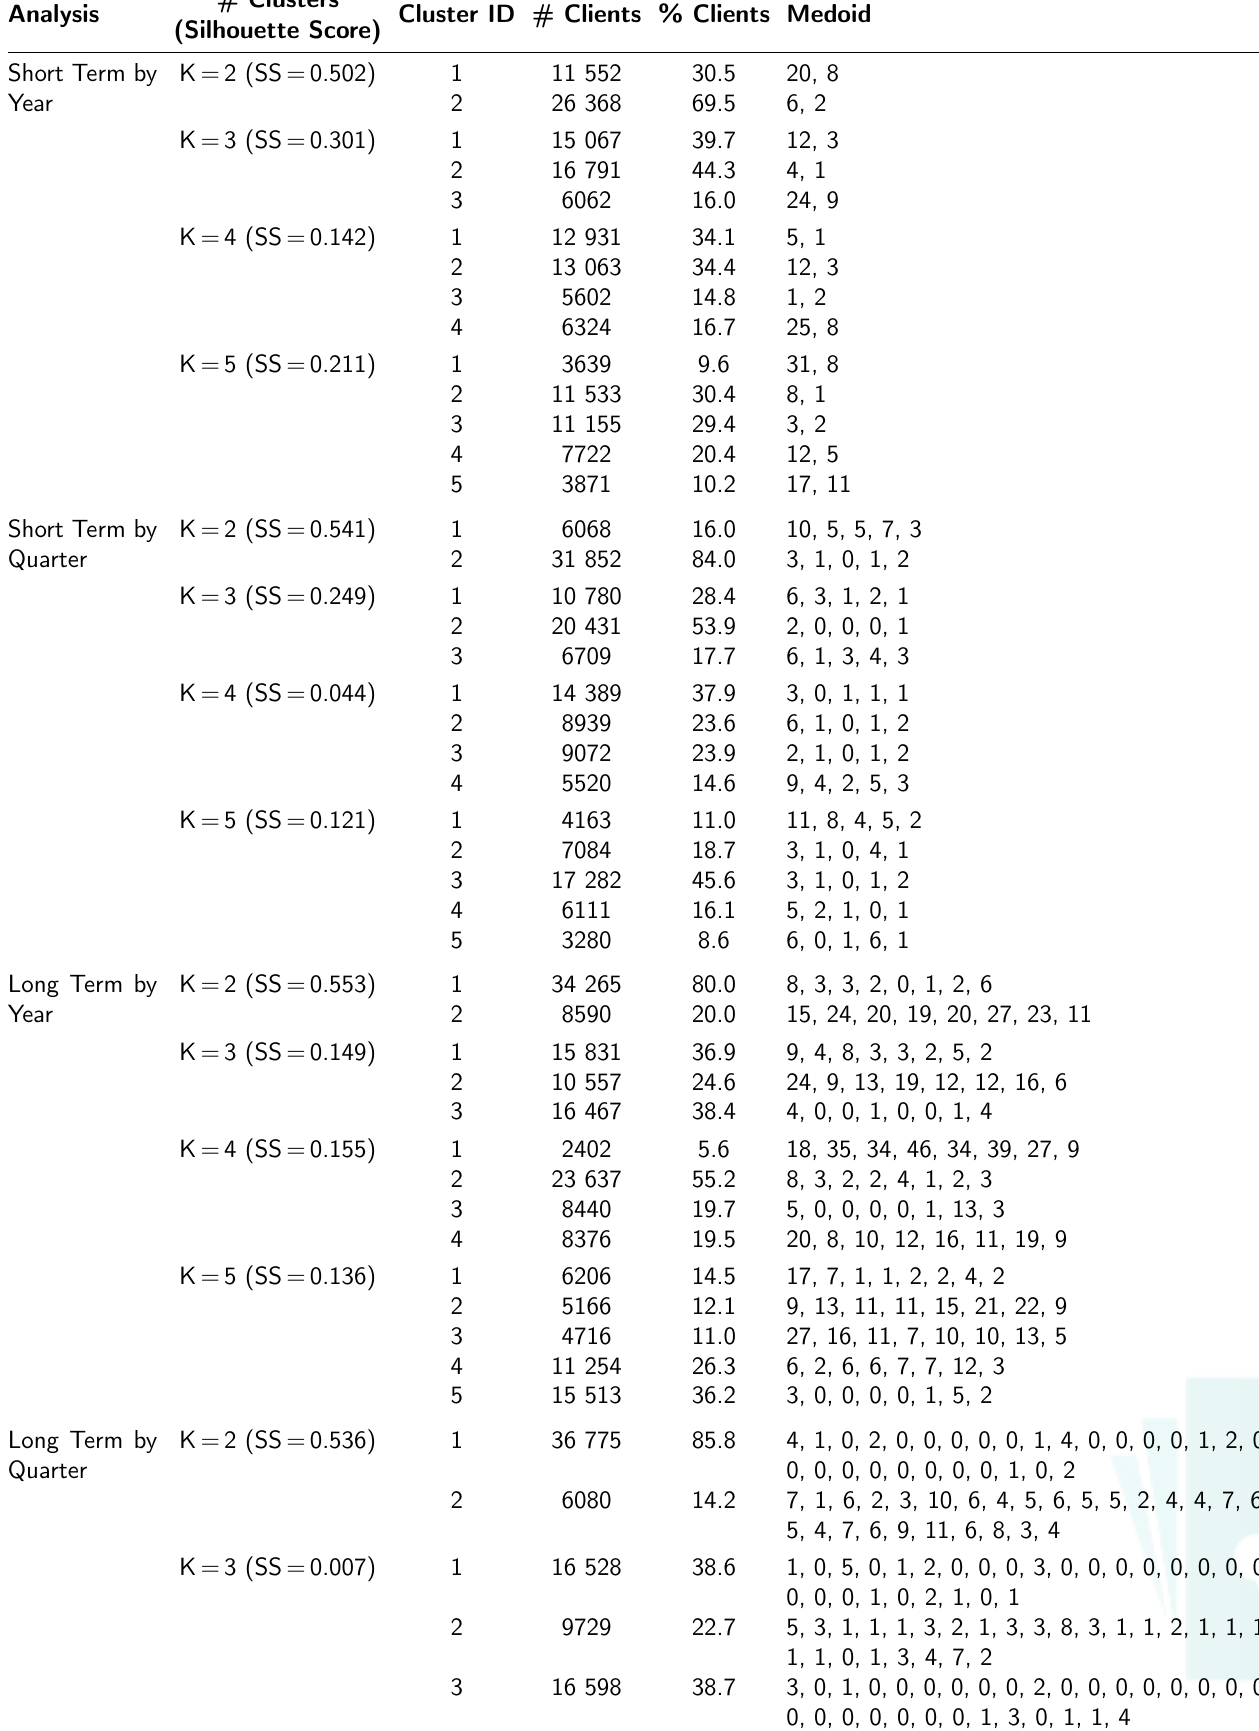
Supplementary Table 5: Time series clustering of care access